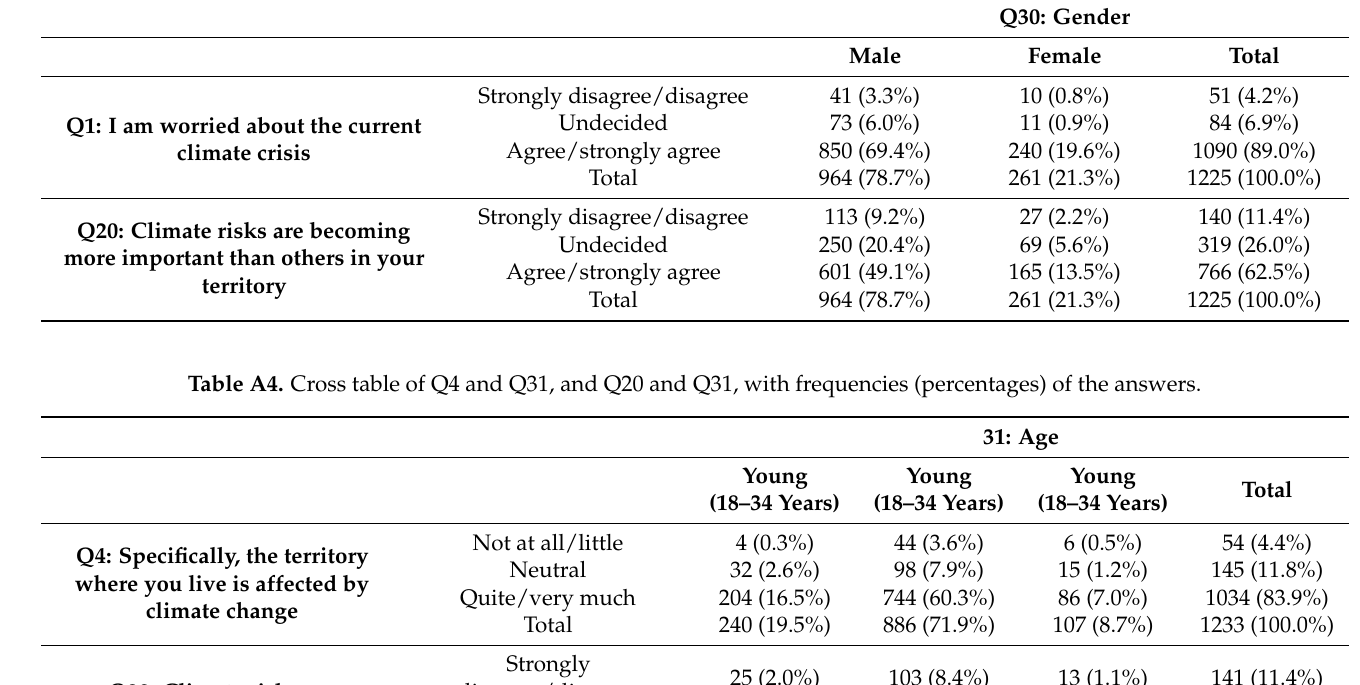
Table A3. Cross table of Q1 and Q30, and Q20 and Q30, with frequencies (percentages) of the answers.